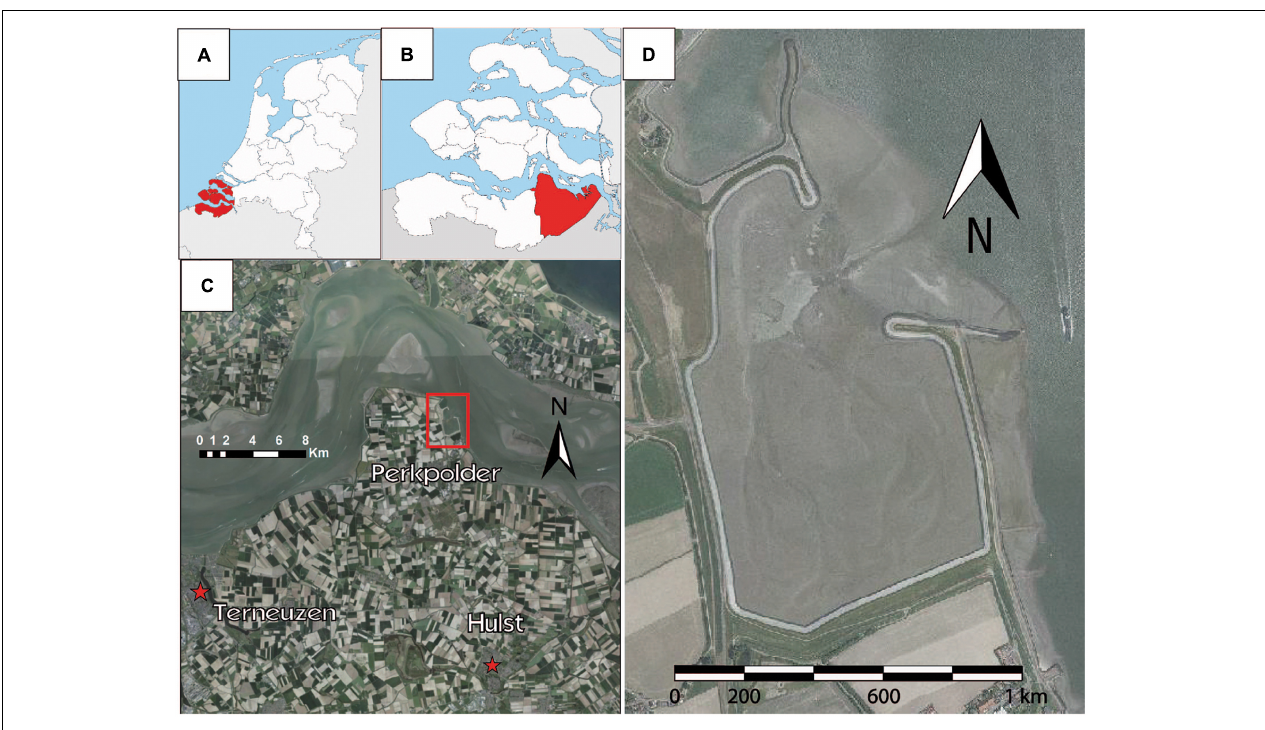
FIGURE 1 | (A) Map of the province of Zeeland and (B) the municipality of Hulst. (C) Location of the Perkpolder tidal basin within the Scheldt Estuary and (D) 1:15000 orthophoto from the Province of Zeeland of the area, captured in June